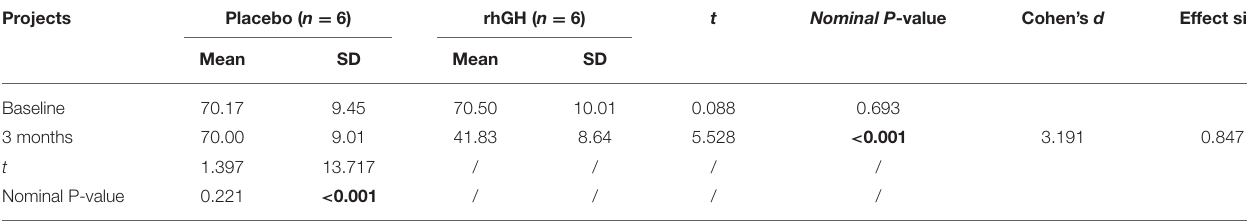
TABLE 6 | Comparison of total SC-ABC score before and after treatment. Projects